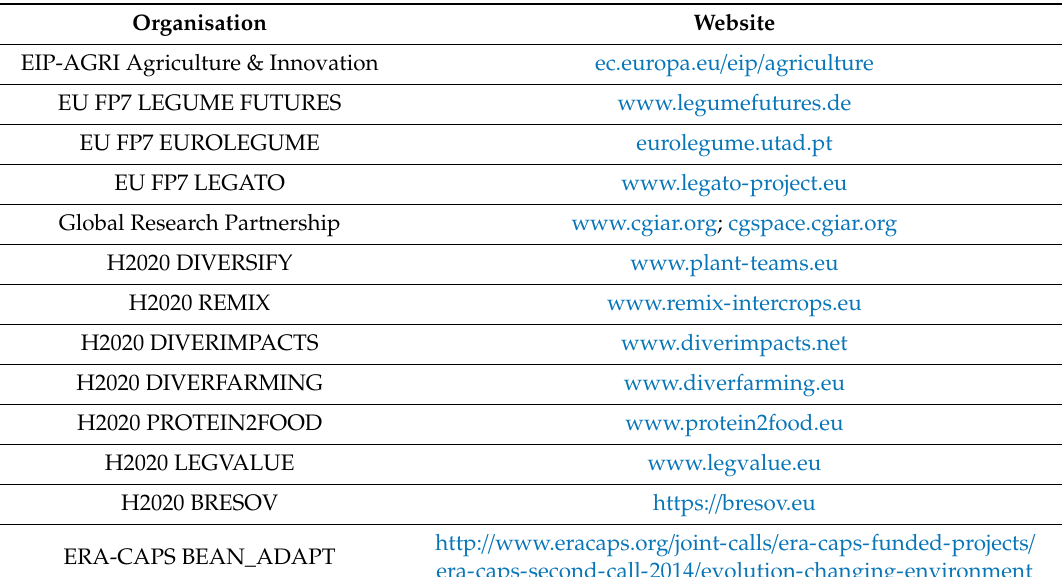
Table 1. Websites of projects, specialist organizations and sources for grey